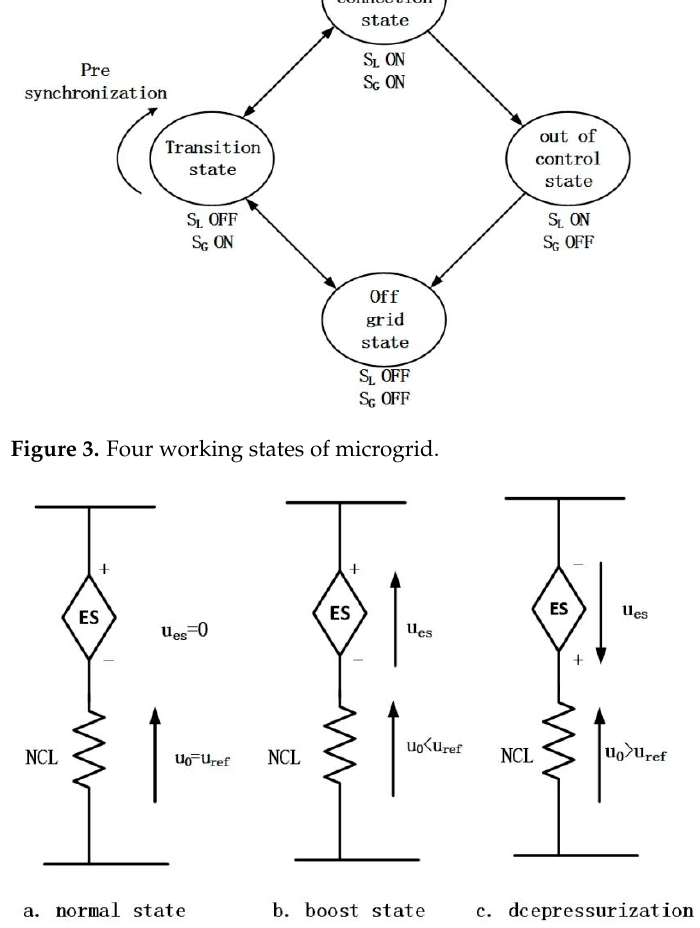
Figure 3. Four working states of microgrid.